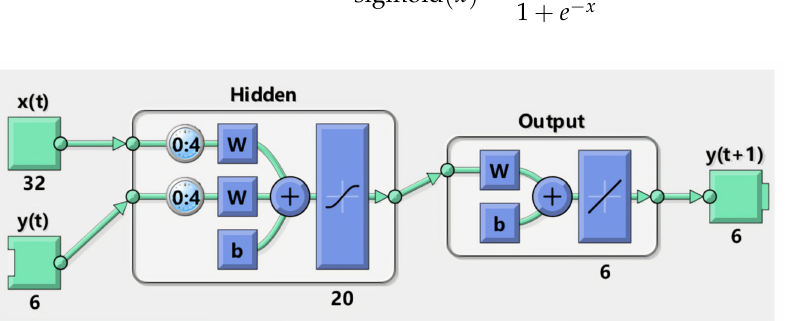
Figure 8. Training setup in MATLAB. The number below each block represents the dimensions. x ( t ) contains RMS and zero crossing (ZC) with 16 dimensions of each, and the y ( t ) is the output feedback of 6. The delay was set to 4. The value of b in the hidden layer and the output layer was set to 0 initially and updated during the